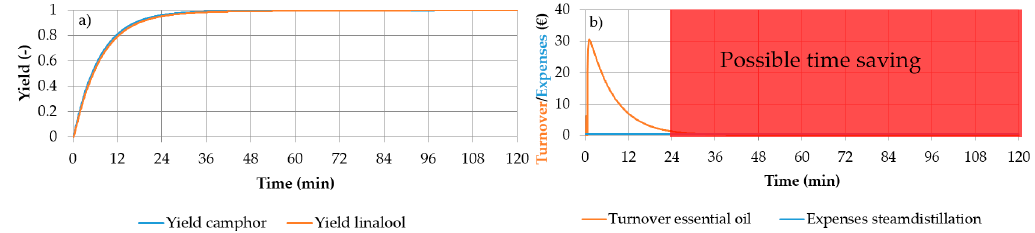
Figure 22. Yield ( a ) and cost ( b ) calculation of Figure 22. Yield (a) and cost (b) calculation of lavender.